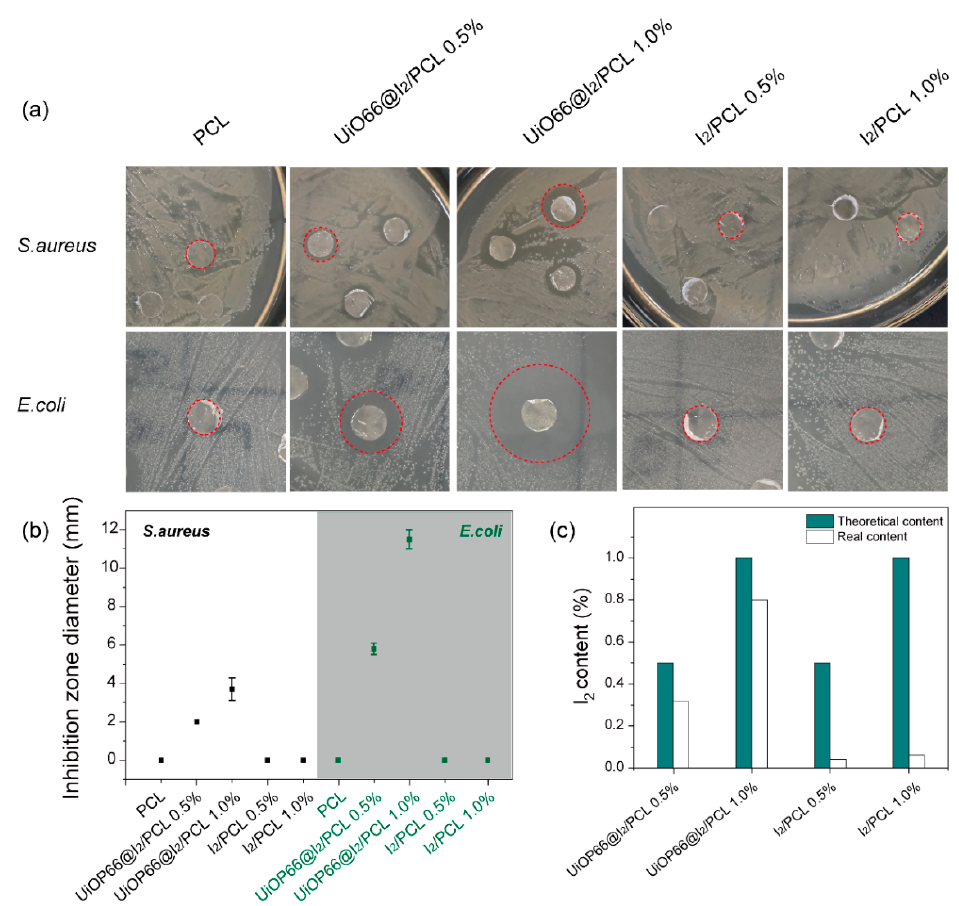
Figure 3. ( a ) Plate photographs of the zone of inhibition test for the PCL composite. ( b ) Inhibition zone diameters corresponding to different composites. ( c ) The theoretical and real iodine contents of various composites.